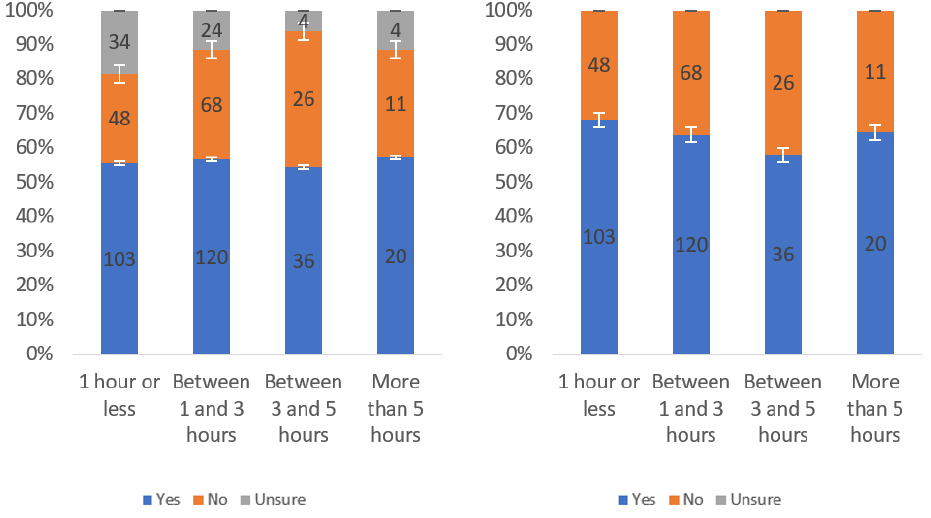
Figure 47. Responses regarding respondents’ willingness to review by internet usage level including ( left ) and excluding ( right ) unsure responses. including ( left ) and excluding ( right ) unsure